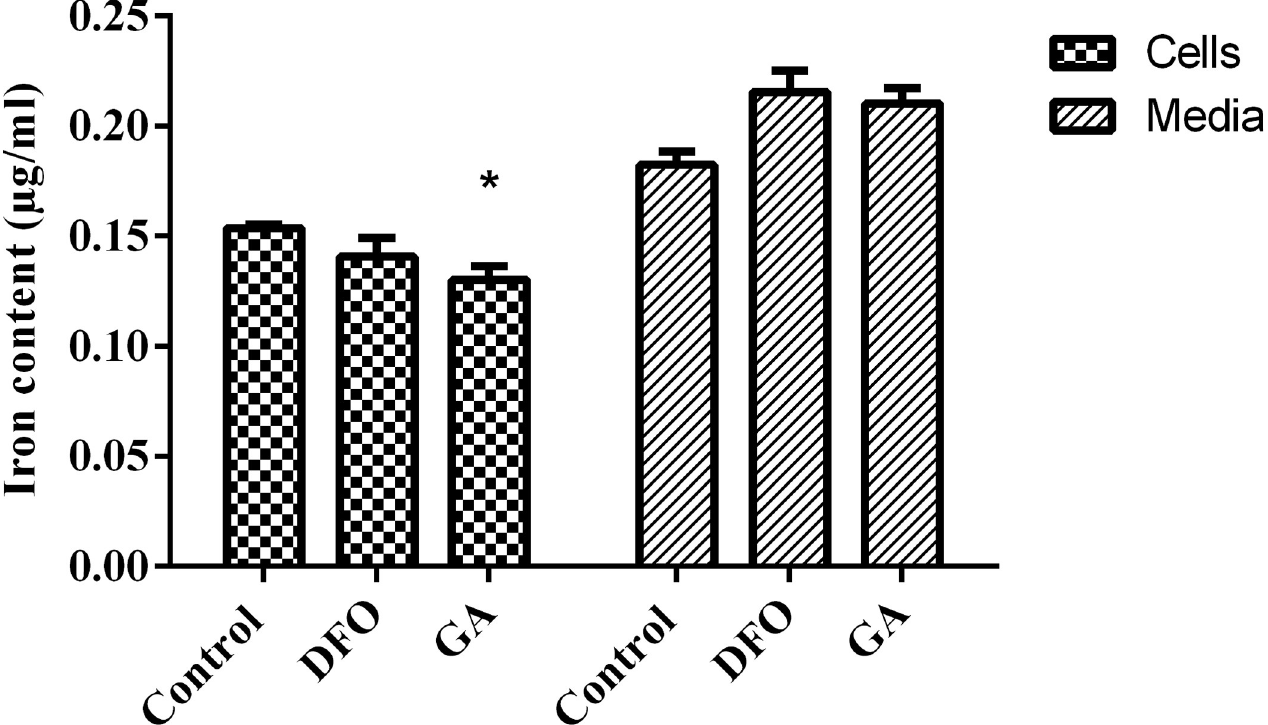
Fig 8. Effect of compounds on intracellular and extracellular iron content. Trypanosomes were treated with 7 μ M of deferoxamine (DFO) and gallic acid (GA). Significance was determined using the unpaired t test comparing treated and control, p < 0 . 05 .